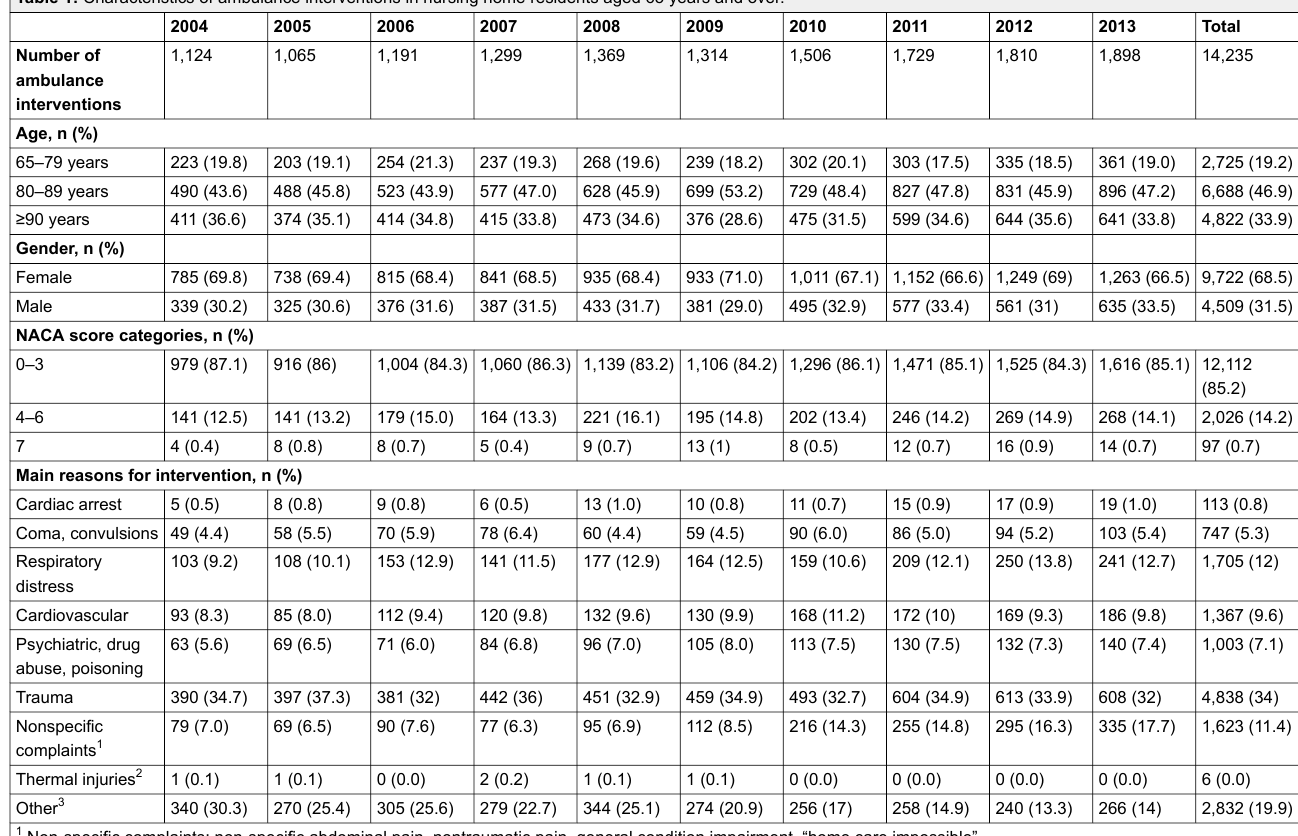
Table 1: Characteristics of ambulance interventions in nursing home residents aged 65 years and